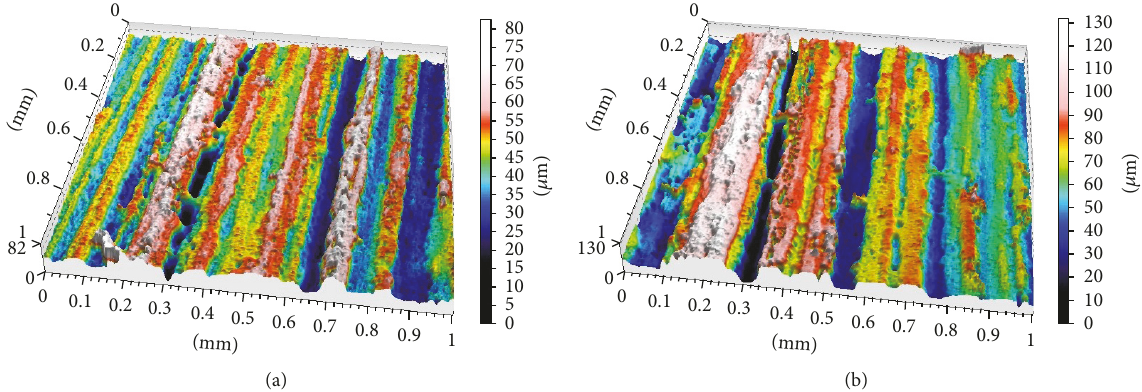
Figure 8: 3D topography of worn contact surface (P240, normal load 20 N): (a) extruded pins and (b) injection moulded